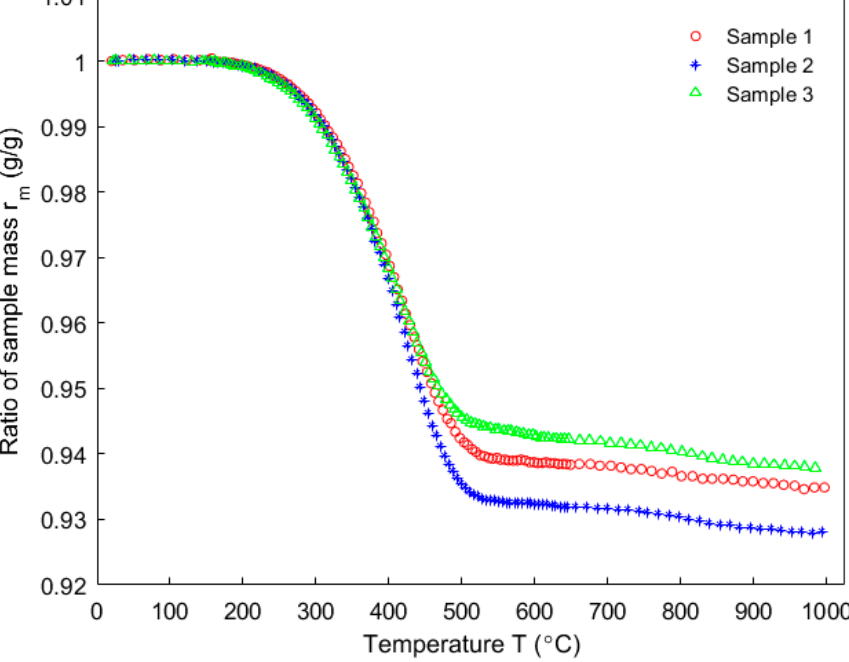
Figure 8. Evolution of sample mass as a function of the temperature.